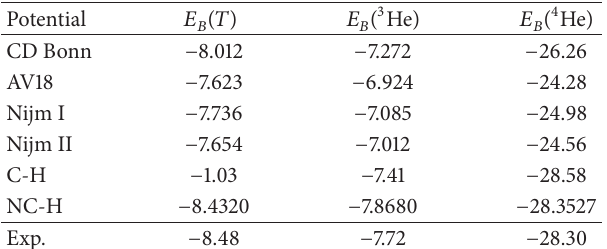
Table 9: 3N and 4N binding energies for various NN potentials [61] compared with our holographic model results and experimental values. C-H and NC-H refer to the critical holographic [39] and noncritical holographic potential [49] models, respectively. All energies are in MeV.